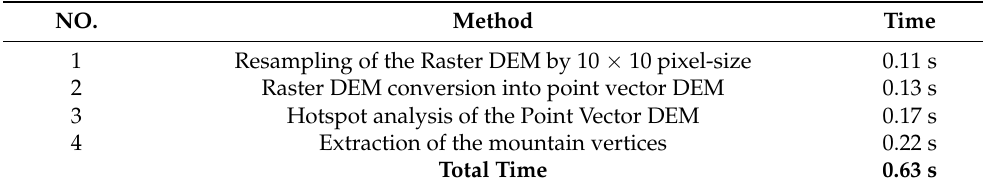
Table 20. The time consumed in extracting mountain vertices for the sixth dataset using our pro- posed approach.